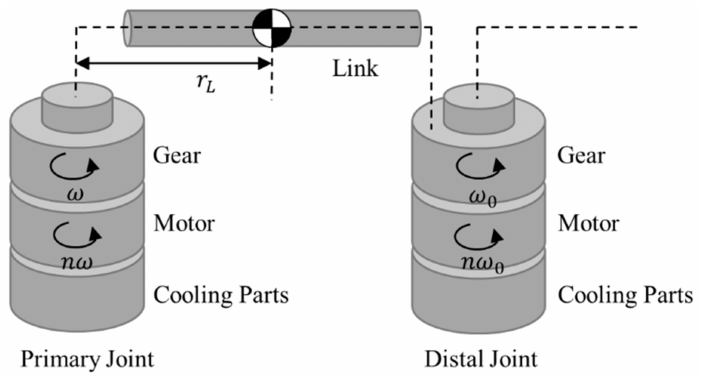
Figure 2. Design scheme of the traditional forced cooling robotic system.